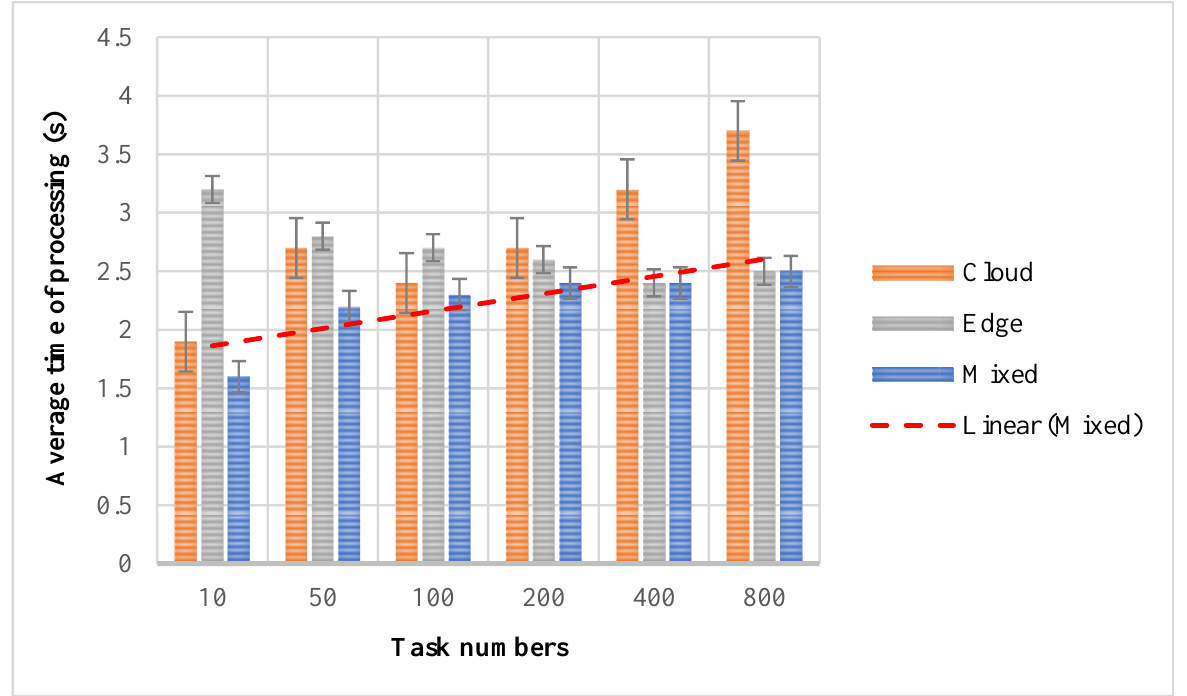
Figure 11. Performance evaluation of various